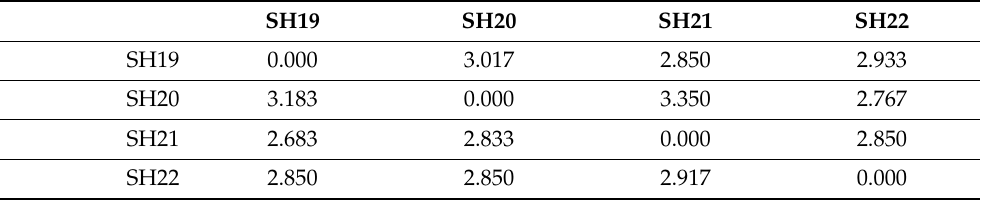
Table 8. Aggregated initial direct-relation matrices—human talent